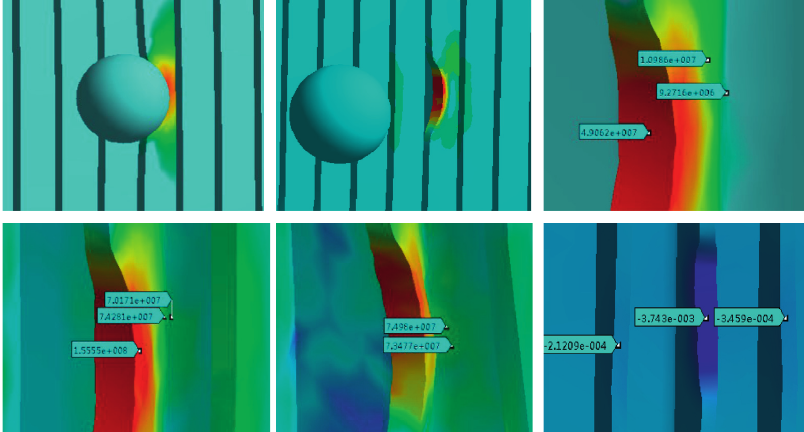
Figure 12: Finite element simulation results. Table 6: Simulation results